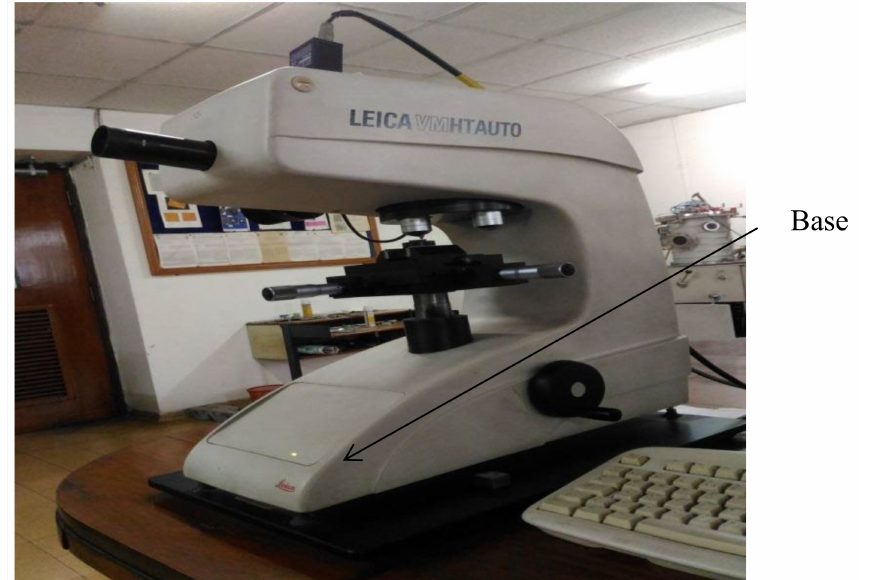
Figure 11. Microhardness tester.